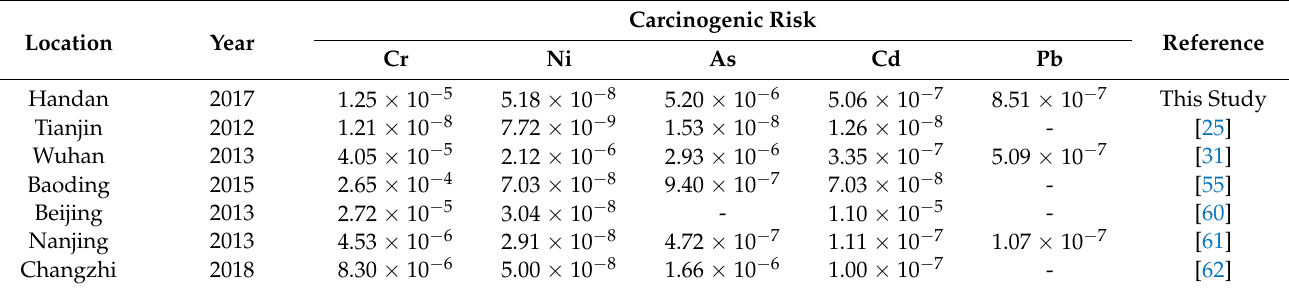
Table 4. Carcinogenic risk of heavy metals in PM 2. 5 in different